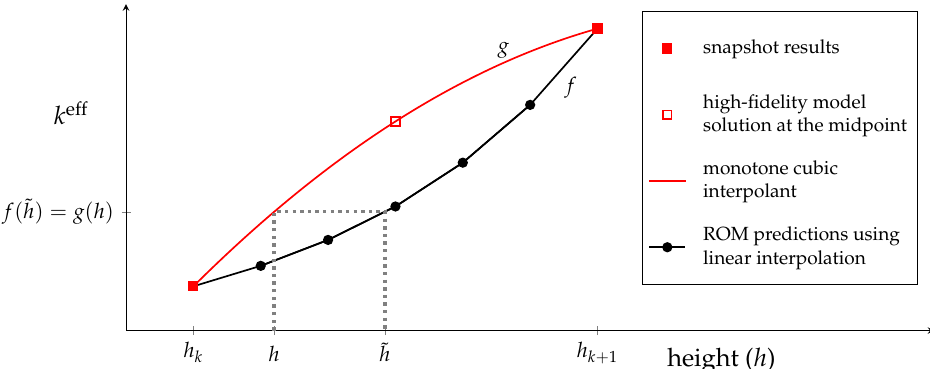
Figure 2. A schematic diagram of the nonlinear map. To find the weight α to be used at height h , locate ˜ h through the relationship g ( h ) = f ( ˜ h ) , where f is the piecewise linear curve passing through the ROM results and g is the (piecewise) cubic Hermitian interpolant through the high-fidelity model results.